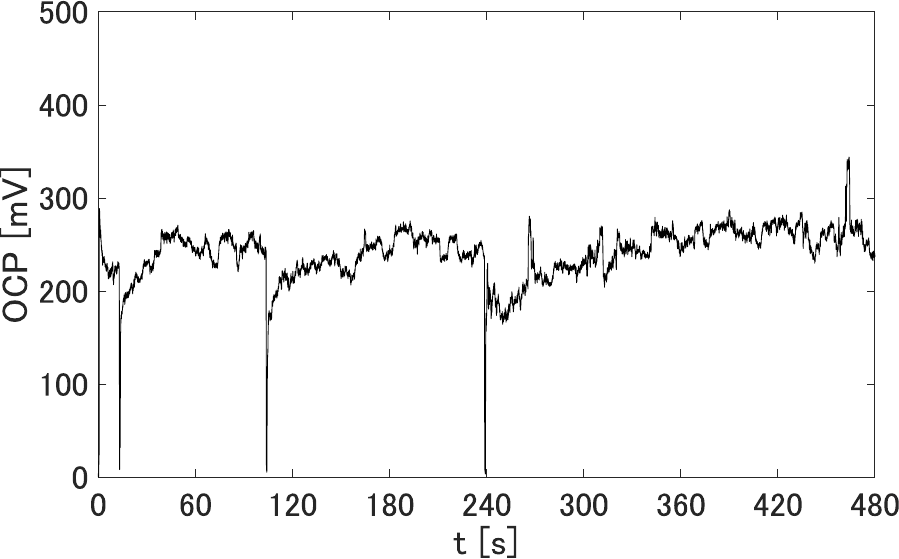
Figure 8. OCP measured after immersing a prototype in 8 mM glucose solution at t = 0. The sampling time was 10 ms and moving mean processing was performed for 10 points. Although OCP was relatively unstable, OCP with a maximum of 344 mV and a mean of 231 mV was observed for 480 s.